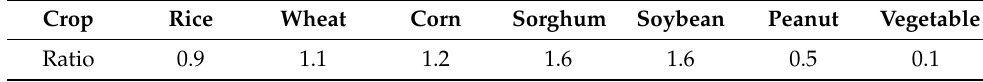
Table 5. Ratio of straw to yield of different